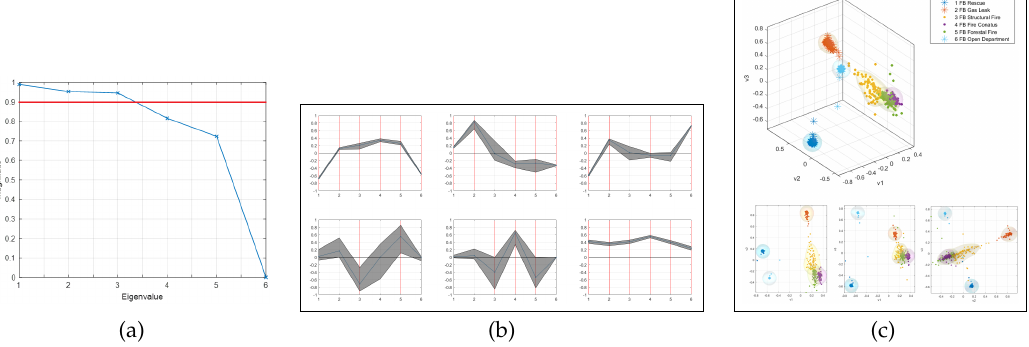
Figure 5. Example of reading the results from extended MCA in fire brigades: ( a ) Eigenvalues represent the importance of each eigenvector. ( b ) Eigenvectors and their confidence intervals, where the x-axis represents the number of categories included in the data matrix, and the y-axis is the amplitude of that category in the projected subspace. ( c ) Joint representation of the projected categories and their confidence areas, with respect to three eigenvectors, and their paired view